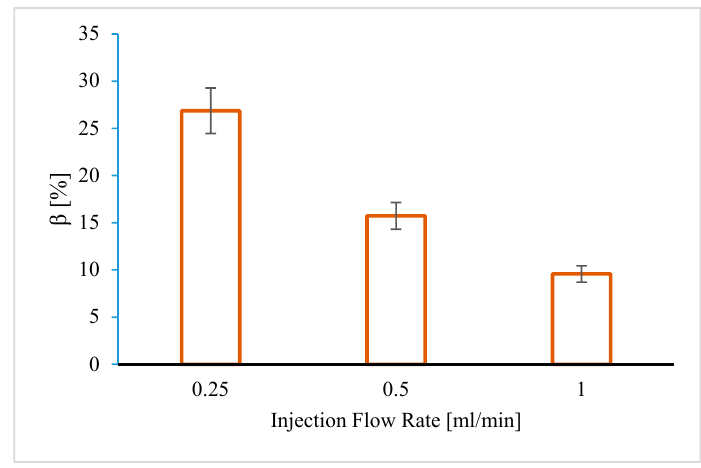
Figure 6 . Effect of injection flow rate on injectivity impairment induced by fines migration. Injectivity impairment decreased with increasing rate of carbonated water injection flow rate.